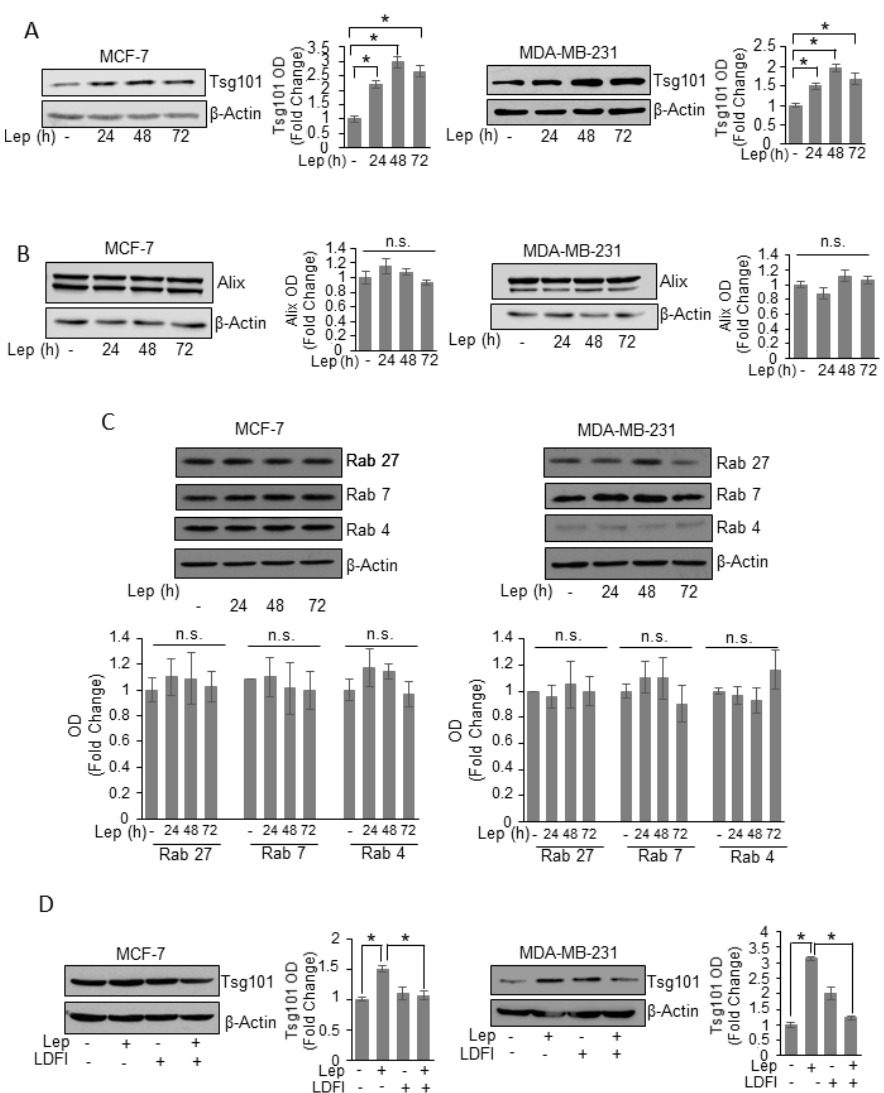
Figure 4. Leptin effects on proteins involved in exosome biogenesis machinery of breast cancer cells. Immunoblots analysis of Tsg101 ( A ), Alix ( B ), Rab 27, Rab 7, and Rab 4 ( C ) in whole cell lysates of MCF-7 and MDA-MB-231 breast cancer cells treated with vehicle (-) or Leptin (Lep, 500 ng/mL) for 24, 48 and 72 h. ( D ) Immunoblot analysis of Tsg101 in whole cell lysate of MCF-7 and MDA-MB-231 breast cancer cells treated with vehicle (-), Leptin and/or LDFI (1 μM) for 48 h. β-Actin was used as a control for equal loading and transfer. The histograms represent the average fold change ± S.D. of three separate experiments in which band intensities were evaluated in terms of optical density arbitrary units (OD), and expressed as fold change versus vehicle-treated samples. * p < 0.05, n.s. nonsignificant.